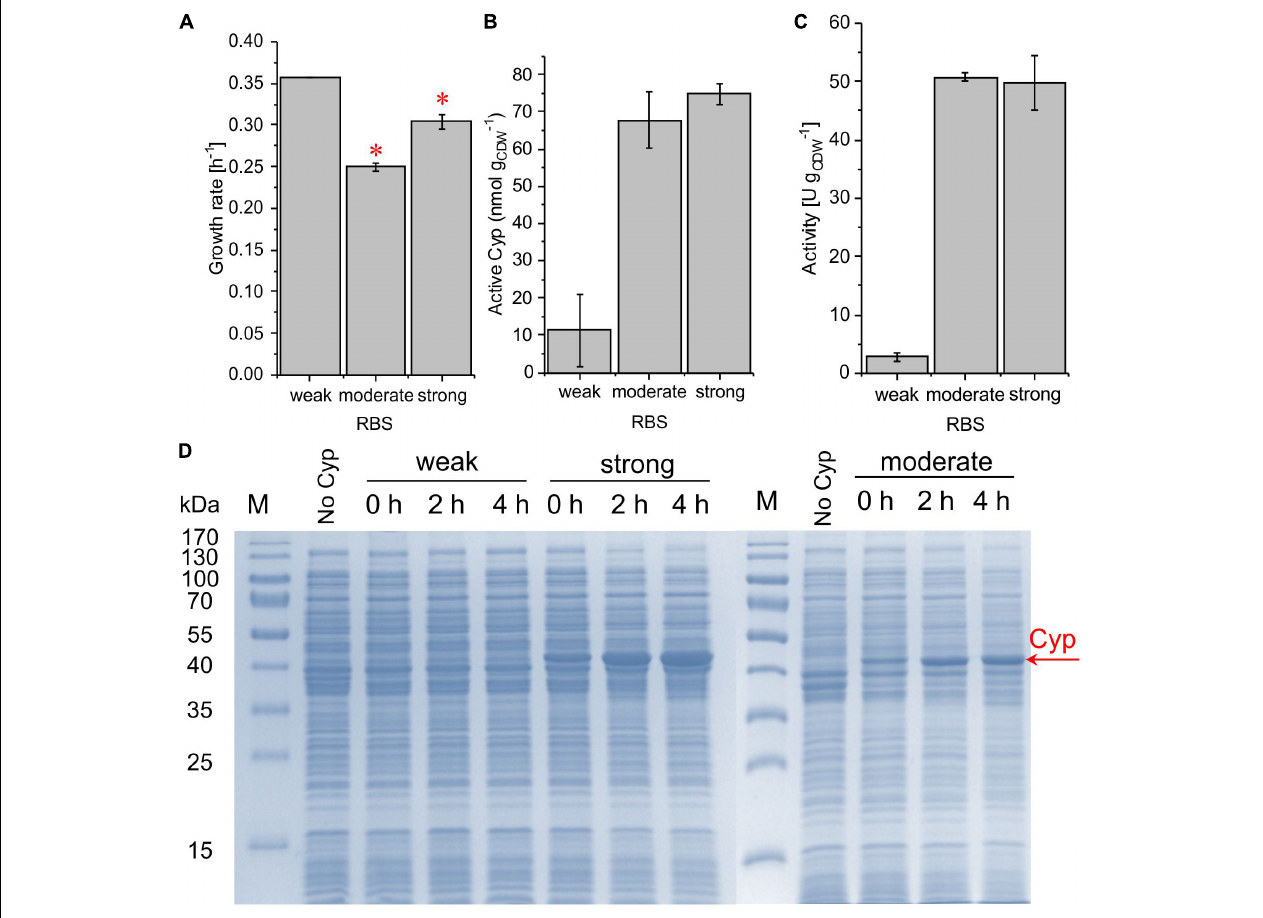
FIGURE 4 | Growth rate (A) , concentration of active Cyp determined via CO difference spectra (B) , and specific cyclohexane hydroxylation activity (C) of P. taiwanensis VLB120 pSEVA254_BB32_Cyp (weak RBS), pSEVA254_RBS ∗ _Cyp (moderate RBS), and pSEVA254_BB34_Cyp (strong RBS) after 4 h of induction. ( ∗ ) Exponential growth only until 1 h after induction, followed by a growth rate decrease. For resting cell assays, cells were processed as described in the legend of Figure 3 . The bars represent average values. Standard deviations of two independent biological replicates are given. The average experimental errors over all measurements for the growth rate, active Cyp concentration, and activity are 7.1, 33.6, and 11.5%, respectively. The high overall error of Cyp concentrations is biased by the low value and big error obtained for the weak RBS. SDS-PAGE analyses (D) of the strains used for activity assays show the corresponding Cyp content (at 47.4